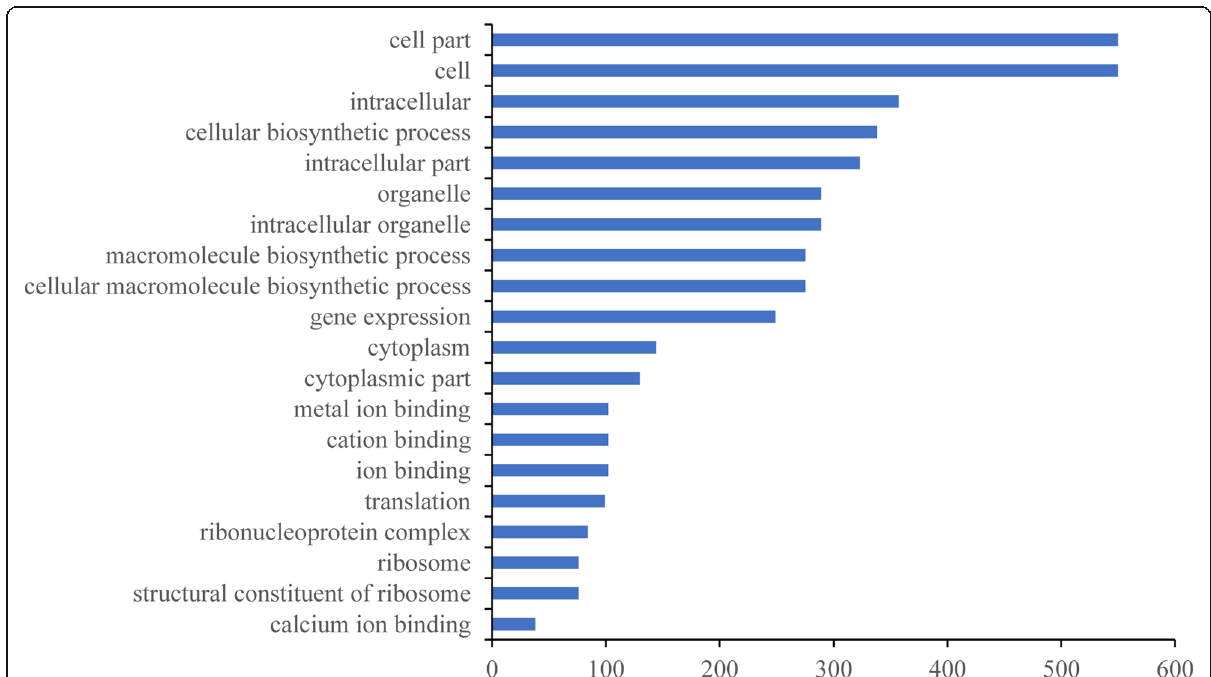
Fig. 6 Number of significantly enriched DEGs associated with the 20 GO enriched terms. The ordinate value (Y-axis) represents the name of the previous 20 GO terms, and the X-axis value represents the number of DEGs enriched in the corresponding